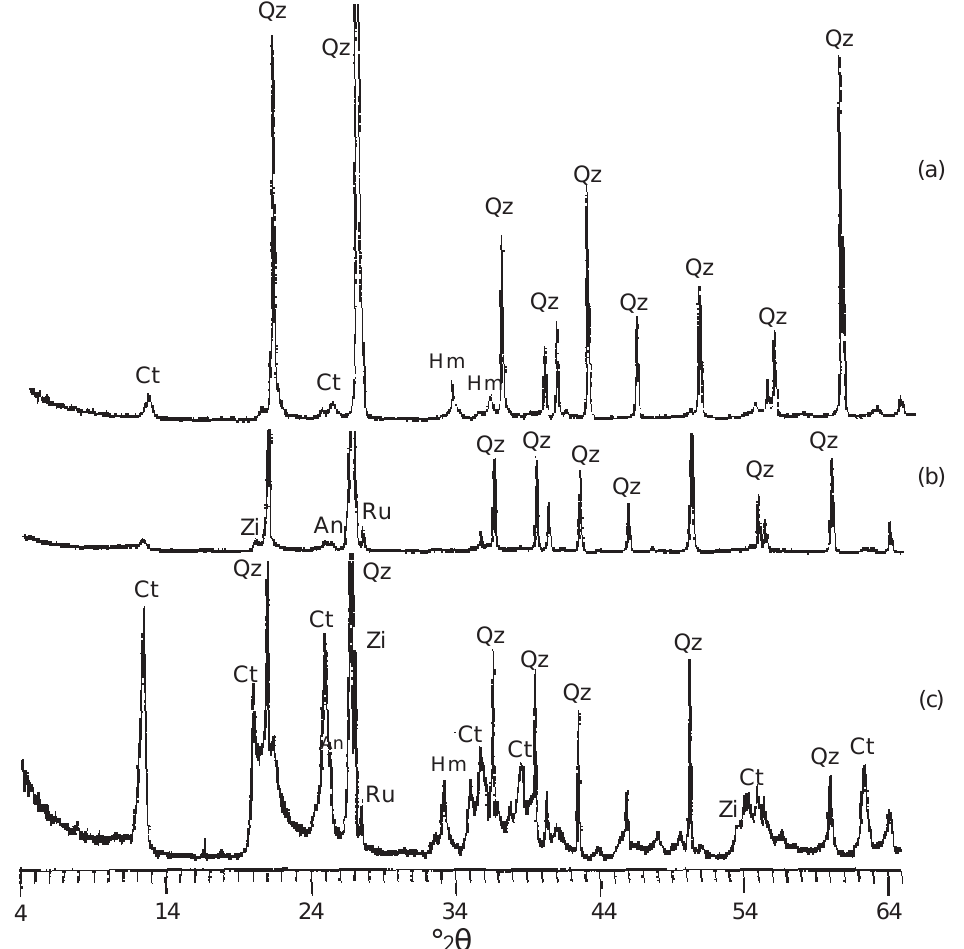
Figura 2. Difratograma de raios-X da fração areia moída (pó) na profundidade de 2,1 m (a) e da fração silte (pó) nas profundidades de 0,7 m (b) e 2,8 m (c) em sedimentos do Grupo Barreiras no município de Aracruz (ES). Qz - quartzo, Ct – caulinita, Hm – hematita, An – anatásio, Ru – rutilo e Zi – zircão.